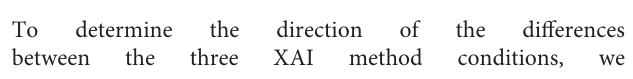
F (6, 226) = 11.2, p < 0.001. The following ANOVA